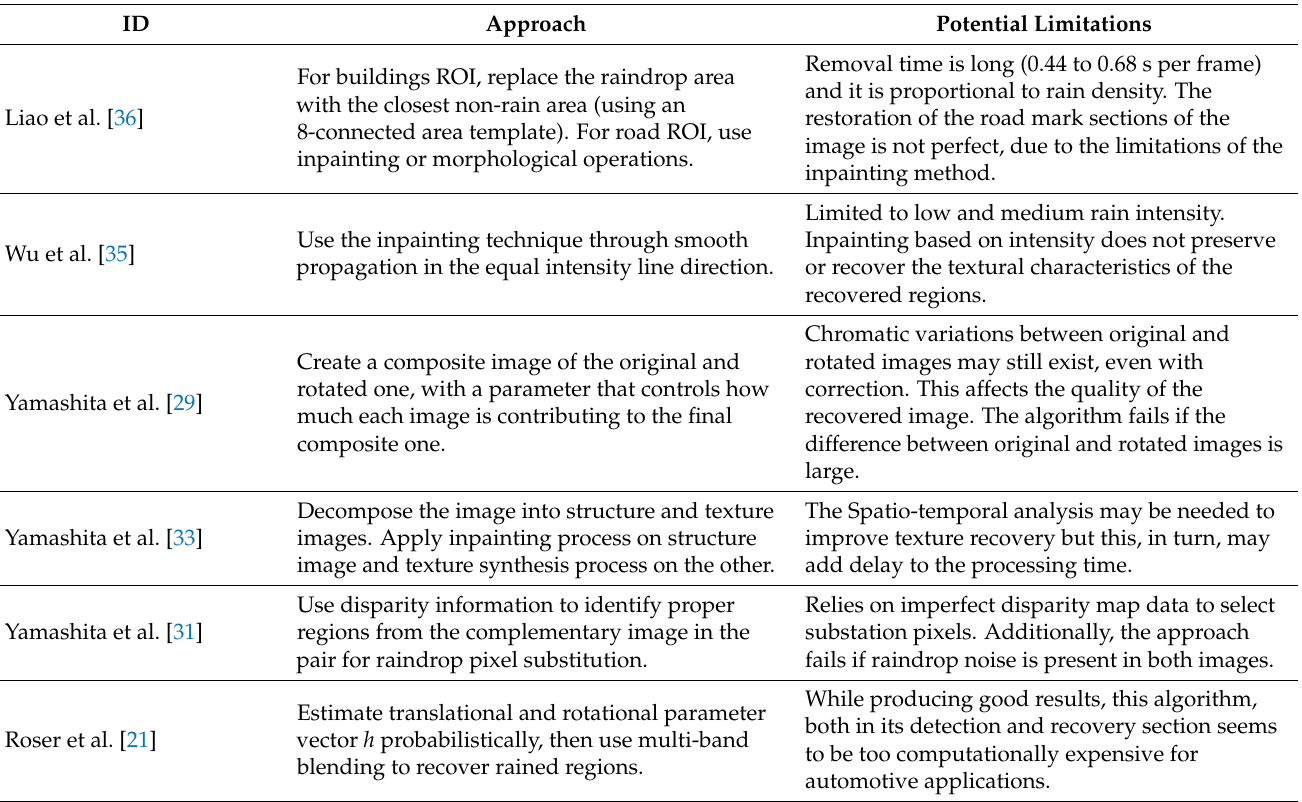
Table 5. Raindrop-Degraded Image